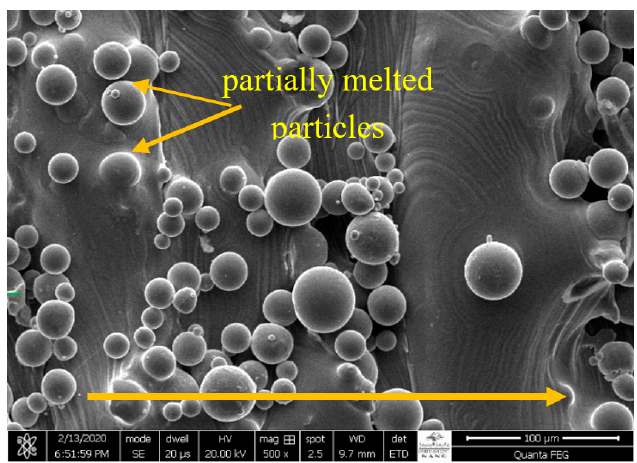
Figure 6. SEM image of the external surface morphology of as-built SLMed Ti6Al4V specimens (arrow shows the building direction).